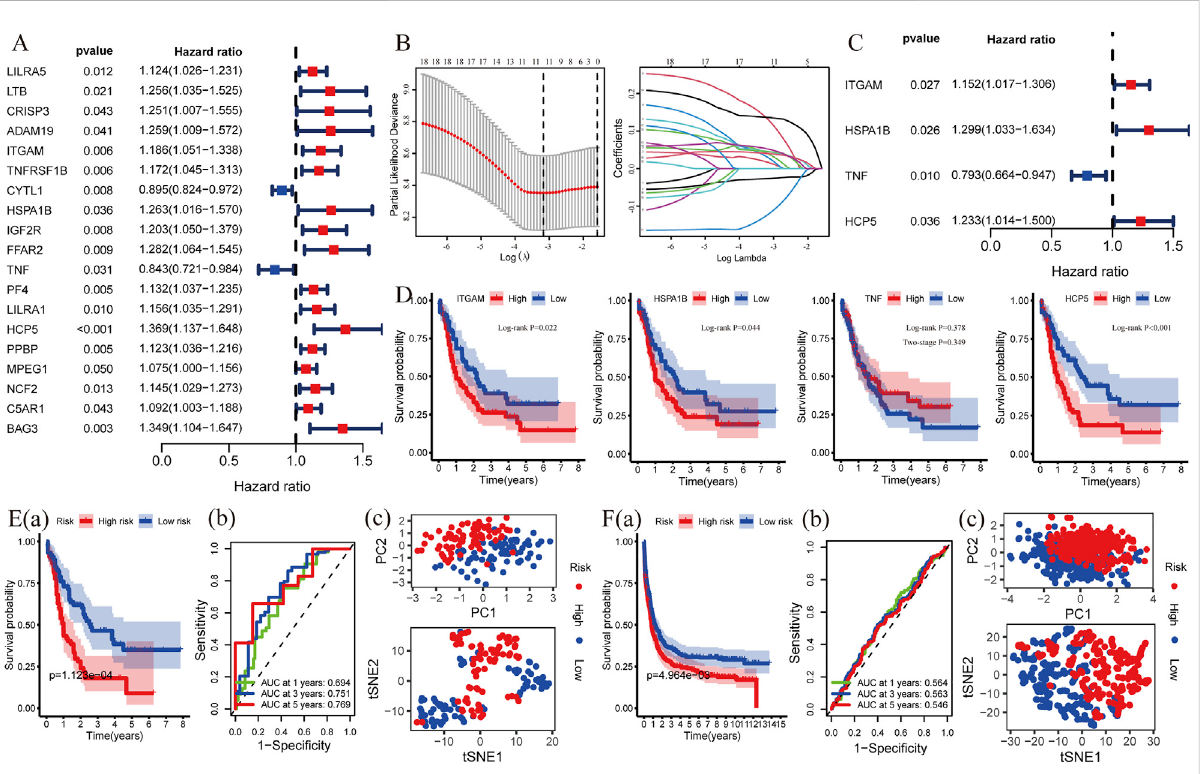
FIGURE 4 Construction and validation of a risk model associated with identifying C-DEGs. (A) Nineteen C-DEGs with prognosis in AML were identi fi ed by univariate Cox regression analysis ( p < 0.05). (B,C) LASSO- and multivariate Cox regression analyses were applied to build a risk model (C-GPM), and theforest mapexhibitedfourC-DEGswith their p values andhazardratios(HR)withcon fi denceintervals (CI). (D) Kaplan – Meiermethod wasusedto calculatetheirdifferencesinoverallsurvival. (E) PredictiveanddiscriminativeabilitiesoftheC-GPMinAMLwereevaluatedbymultiplemethods, including survival- (a) , ROC- (b) , PCA-, and t-SNE (c) analyses. (F) Validation of the predictive and discriminative abilities of the C-GPM in the GSE37642